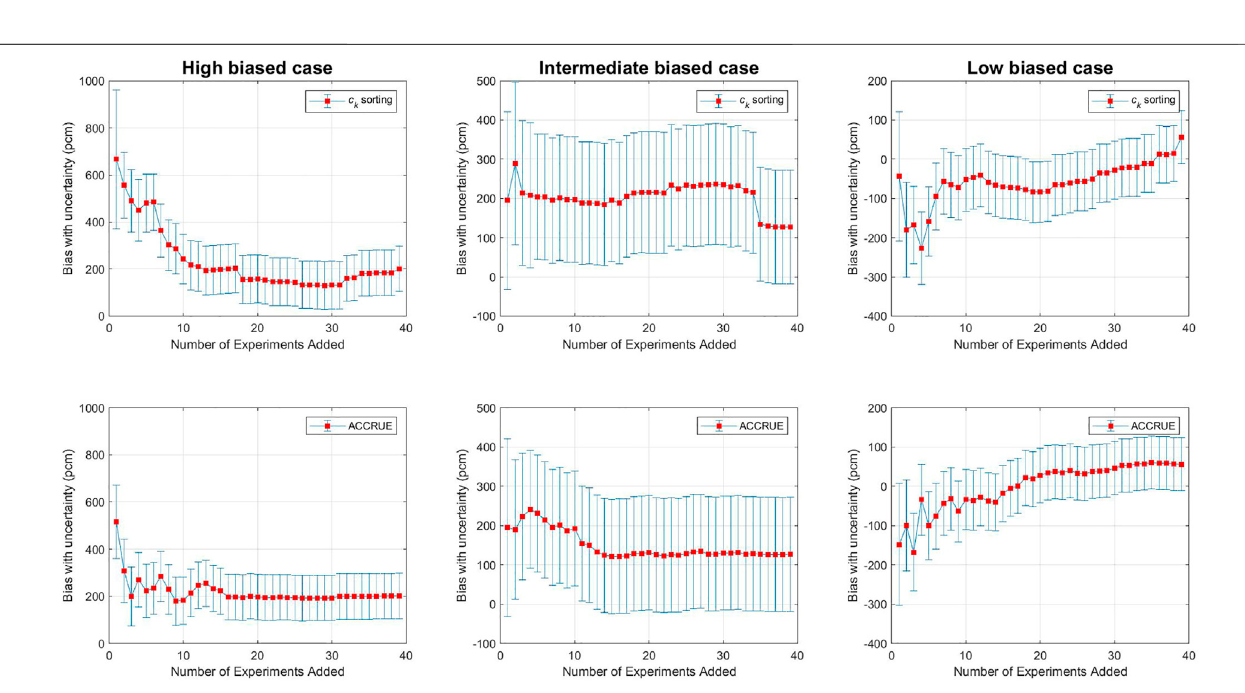
FIGURE 9 | Bias and uncertainty estimation for high relevance